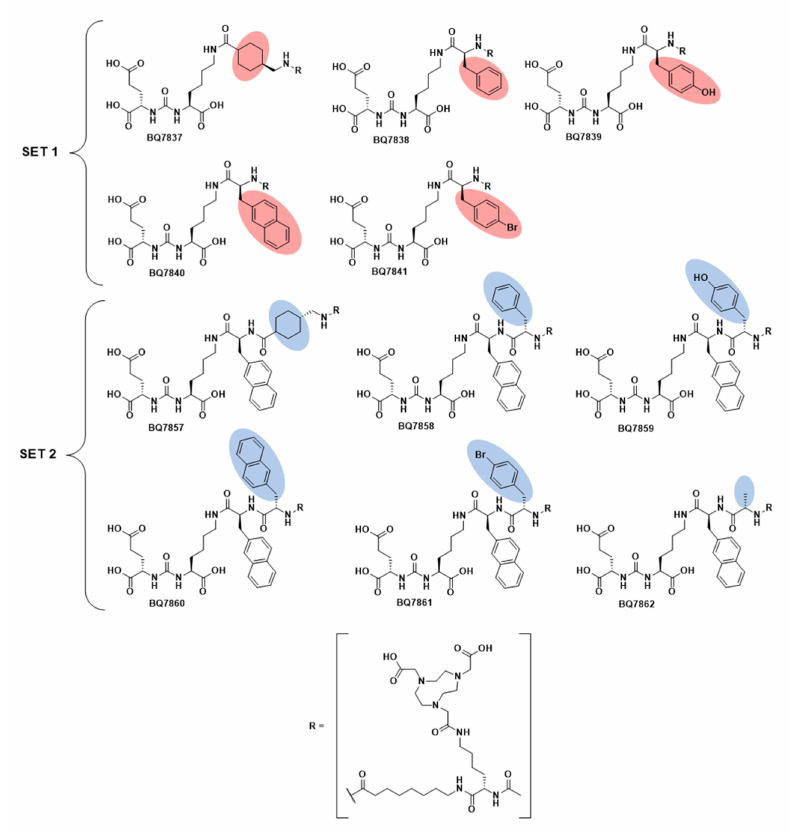
Figure 2. Chemical structure of compound BQ7837-BQ7841 (SET 1) and BQ7857-BQ7862 (SET